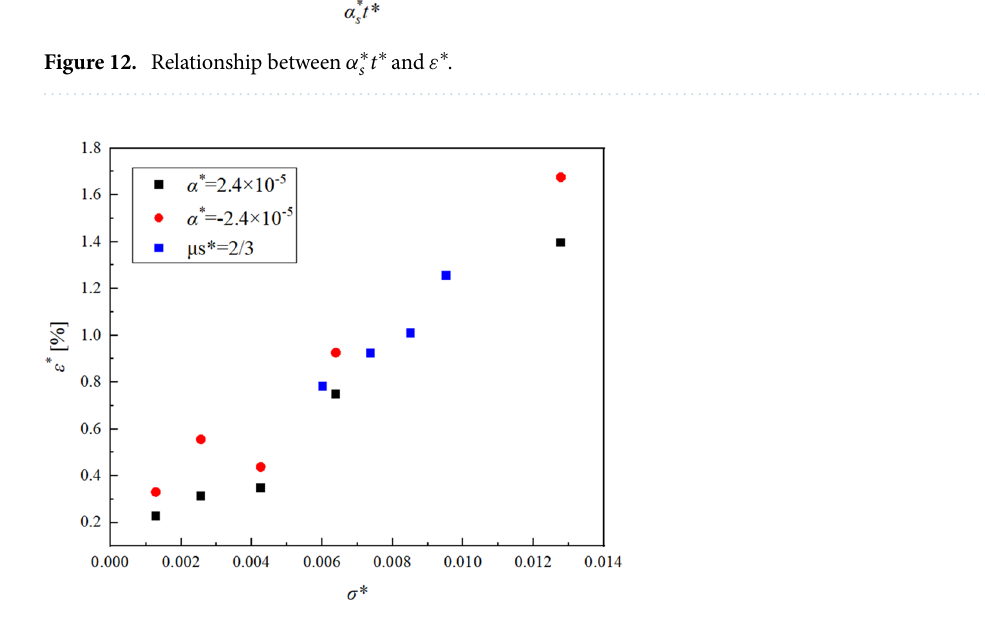
Figure 13. Relationship between σ ∗ and ε ∗